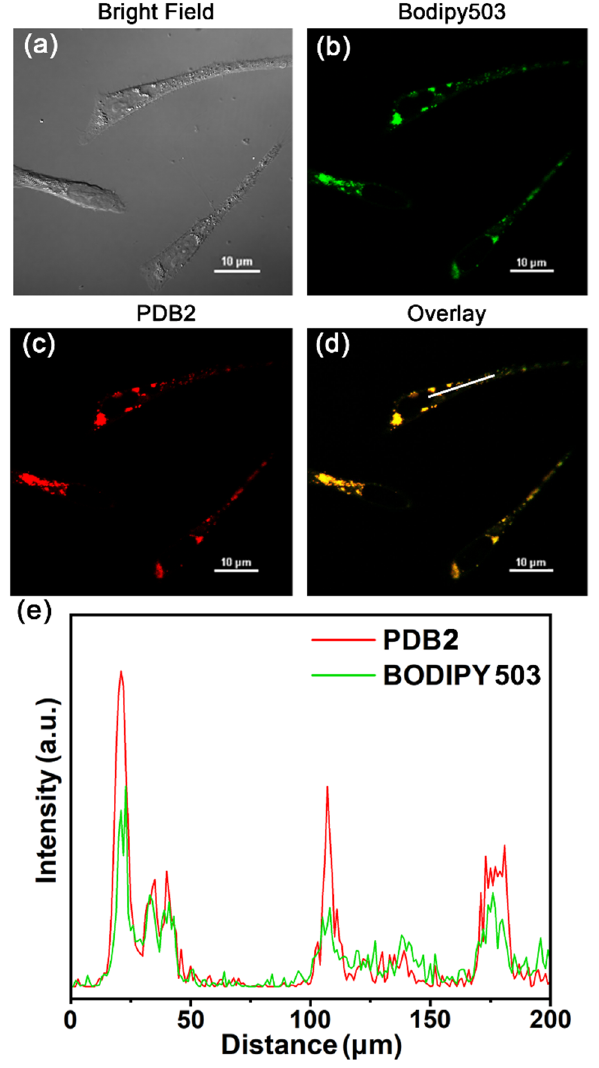
Figure 6. ( a ) Bright-field images of PDB2. ( b , c ) CLSM image of HeLa cells with BODIPY 503 (10 μ M) and PDB2 (10 μ M). ( d ) The merged images with BODIPY503 and PDB2. ( e ) The intensity profile of ROI lines. Scale bar = 200 μ M (red and green channel, excitation wavelength, etc.).